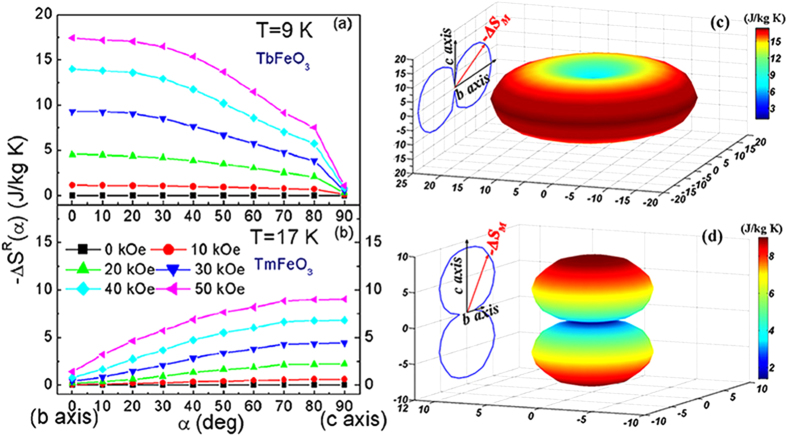
Rotating field entropy changes −ΔSR(α) from b axis to c axis vs magnetic field.(a) of TbFeO3 single crystal at 9 K; (b) of TmFeO3 single crystal at 17 K; (c) “expected” anisotropy of magnetic entropy change of TbFeO3 single crystal; and (d) “expected” anisotropy of magnetic entropy change of TmFeO3 single crystal.